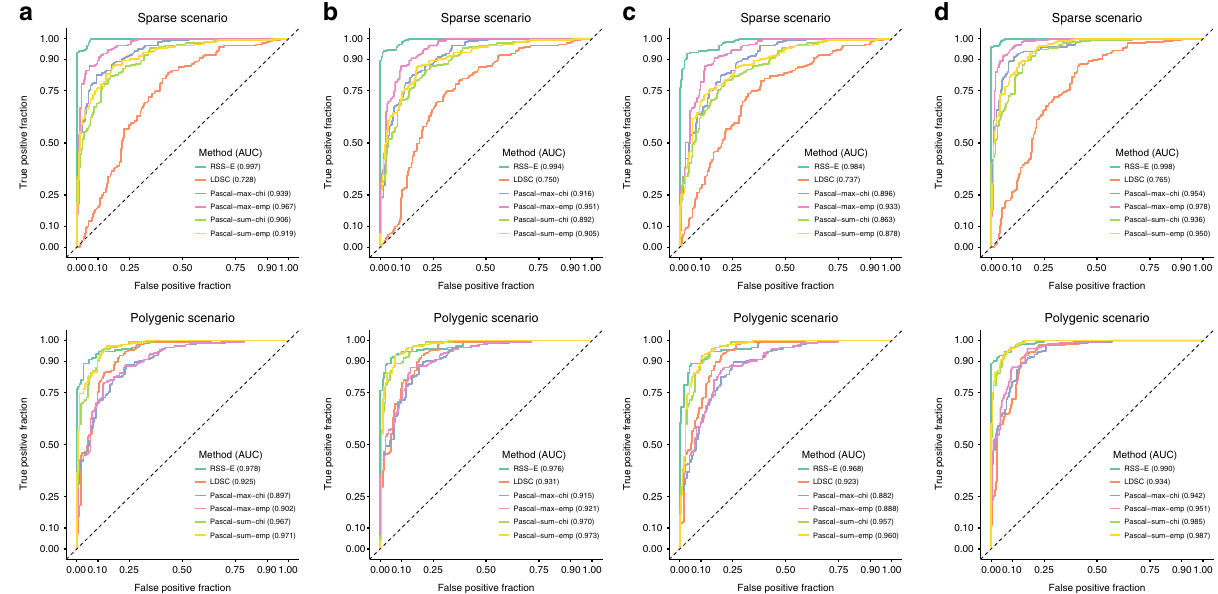
Fig. 2 Comparison of RSS-E to other methods for identifying enrichments from GWAS summary statistics. We used real genotypes 12 to simulate individual- level data under two genetic architectures ( “ sparse ” and “ polygenic ” ) with four baseline-enrichment patterns: a baseline and enrichment datasets followed baseline ( M 0 ) and enrichment ( M 1 ) models in RSS-E; b baseline datasets assumed that a random set of near-gene SNPs were enriched for genetic associations and enrichment datasets followed M 1 ; c baseline datasets assumed that a random set of coding SNPs were enriched for genetic associations and enrichment datasets followed M 1 ; d baseline datasets followed M 0 and enrichment datasets assumed that trait-associated SNPs were both more frequent, and had larger effects, inside than outside the target gene set. We computed the corresponding single-SNP summary statistics, and, on these summary data, we compared RSS-E with Pascal 13 and LDSC 14 using their default setups. Pascal includes two gene scoring options: maximum-of- χ 2 (-max) and sum-of- χ 2 (-sum), and two pathway scoring options: χ 2 approximation (-chi) and empirical sampling (-emp). For each simulated dataset, both Pascal and LDSC produced enrichment p values, whereas RSS-E produced an enrichment BF; these statistics were used to rank the signi fi cance of enrichments. Each panel displays the trade-off between false and true enrichment discoveries for all methods in 200 baseline and 200 enrichment datasets of a given simulation scenario, and also reports the corresponding areas under the curve (AUCs), where a higher value indicates better performance.